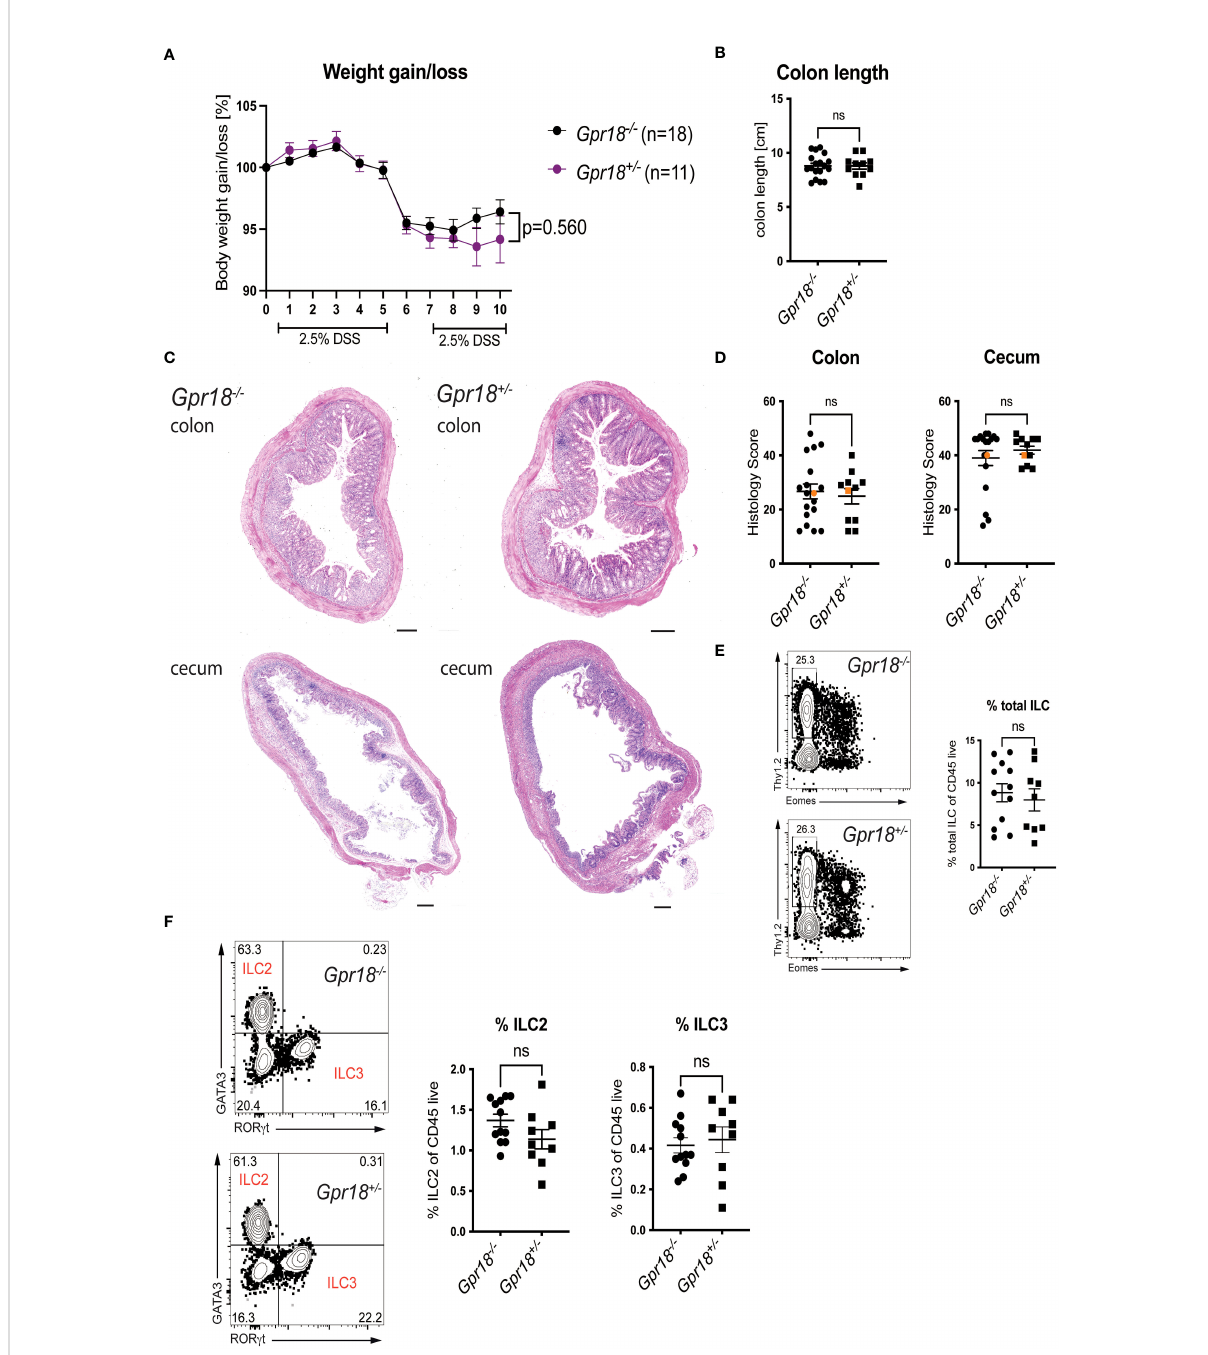
FIGURE 3 GPR18 does not play a role in the DSS model of colitis. Colitis was induced in Gpr18 -/- and control littermates ( Gpr18 +/- ) by two cycles of 2.5% DSS for 5 days followed by two days of water and disease progression was monitored. (A) Mice were weighed daily for 10 days and bodyweight change as % starting weight was determined. Data was combined from three independent experiments. (B) Colon lengths at end point. (C) H&E staining of representative distal colon and cecum sections from at 40x (scale bar 200 m m) magni fi cation. (D) Blinded histology scores from distal colon and cecum combined from 3 independent experiments. The representative images were taken from mice represented by the orange colored data points. (E) Percentage of total ILC isolated from the colon lamina propria from two independent DSS colitis experiments. Total ILC were gated as Thy1.2 + CD45 + LIN - CD3 - , Lineage markers were CD19, B220, CD11c and Gr1. (F) Percentage of ILC2 and IlC3 isolated from the colon lamina propria from two independent DSS experiments. ILC2 were gated as CD45 + LIN - CD3 - Thy1.2 + Eomes - GATA3 + and ILC3 were gated as CD45 + LIN - CD3 - Thy1.2 + Eomes - ROR g t + . Error bars represent S.E.M. Two-way ANOVA (Tukey ’ s test) (A) and nonparametric T-test (Mann- Whitney test) (B, D – F) . ns, not signi fi